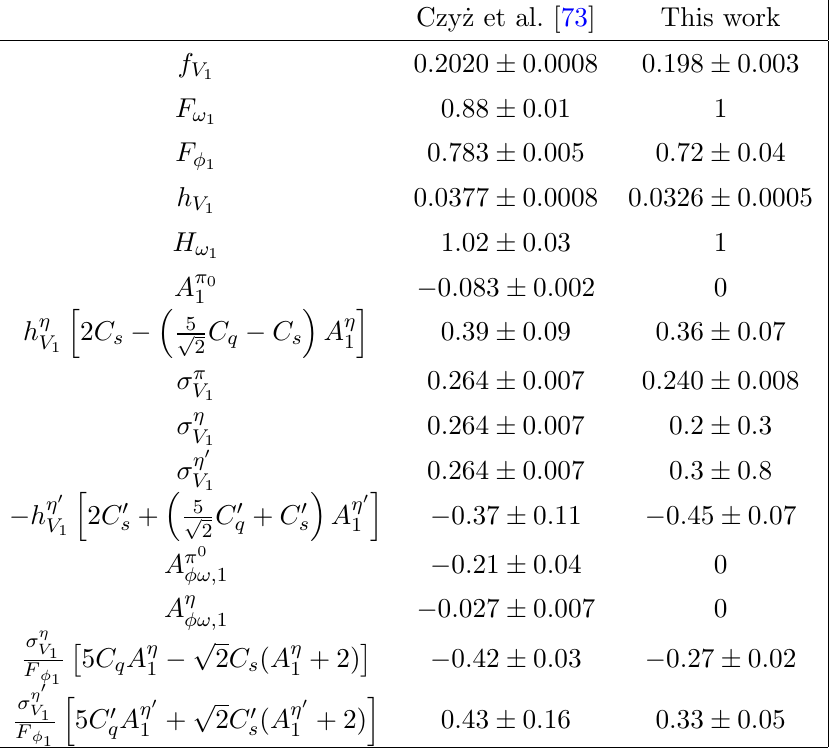
Table 11 . Numerical values for the linear combinations of constants shown in table 10, reported in ref. [73], compared to the values obtained from our